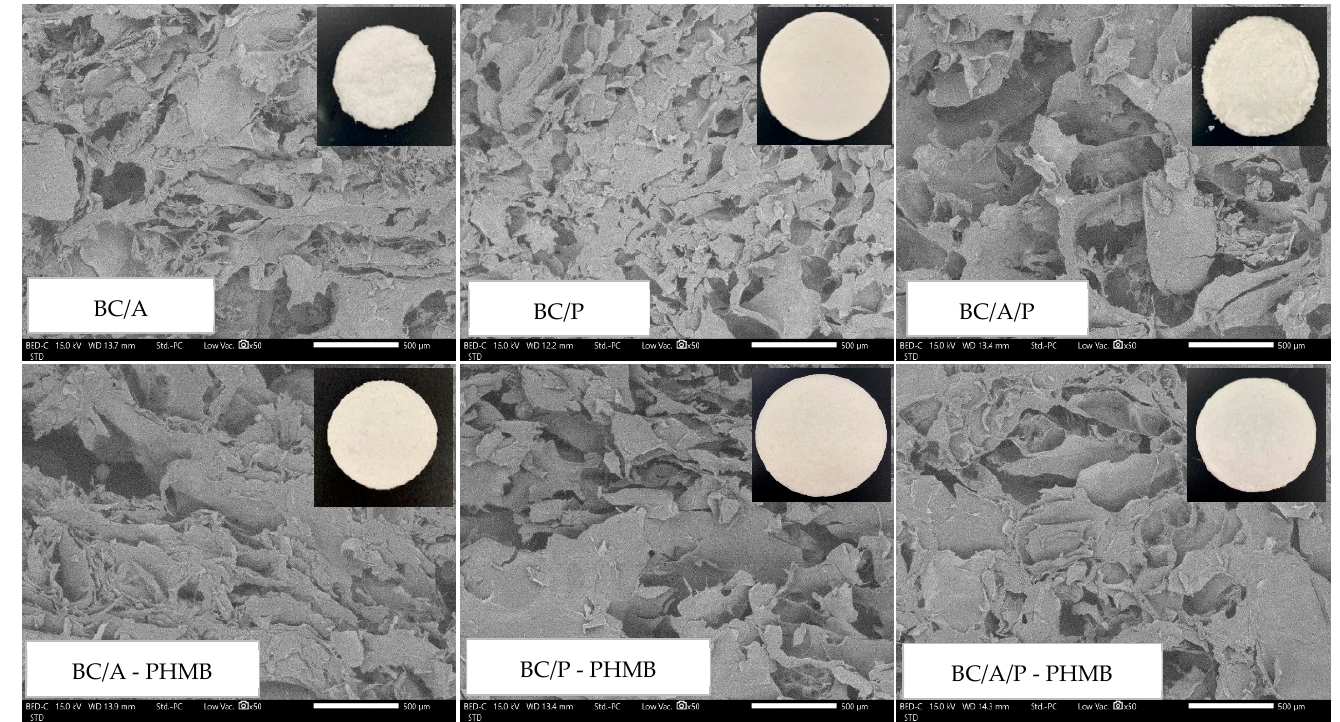
Figure 1. Cross section of sponges composed of BC and incorporated with or without PHMB using SEM at 50×. Table 2. Thickness, diameter, and puncture strength of hydrogels containing BC.